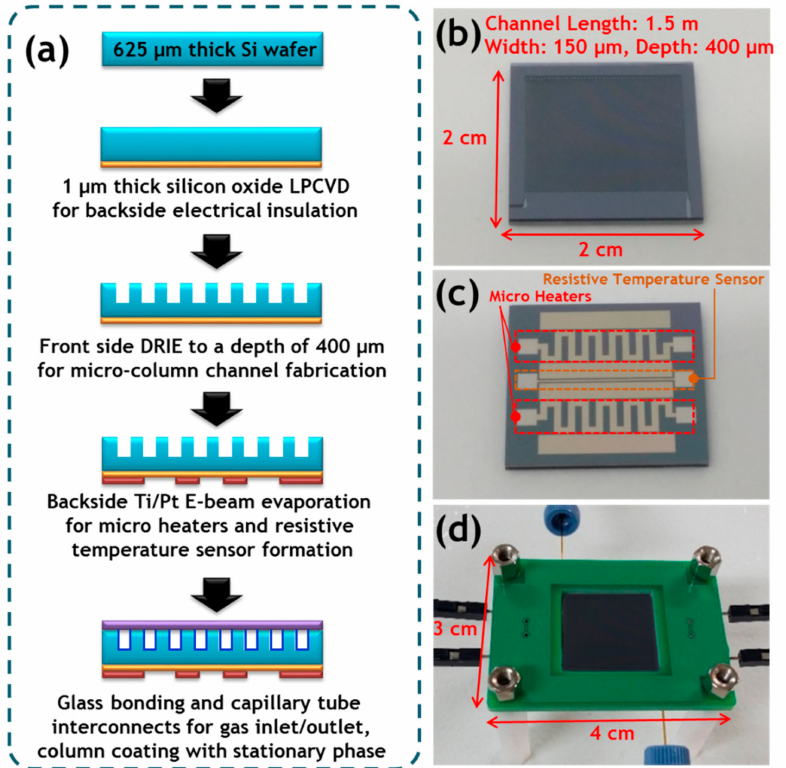
Figure 2. Fabrication of the bump structure µ -GC module. ( a ) Fabrication process flow of the bump structure µ -GC column; ( b ) front side of the chip showing the bump structure µ -GC column; ( c ) back side of the chip showing patterned platinum micro-heaters and resistive temperature sensor (RTS) for temperature control of the µ -GC column; ( d ) packaged µ -GC module with the fused-silica capillary tube, micro-capillary adapters, etc. (size: 3 cm × 4